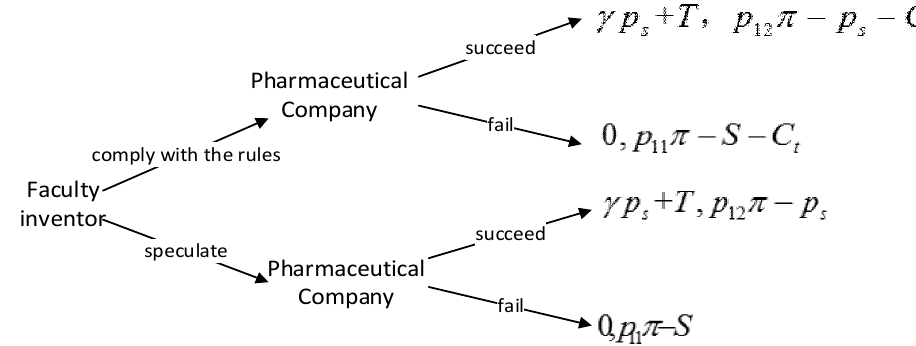
Figure Figure 12. The decision-making tree of the game model between faculty inventors and pharmaceutical companies.